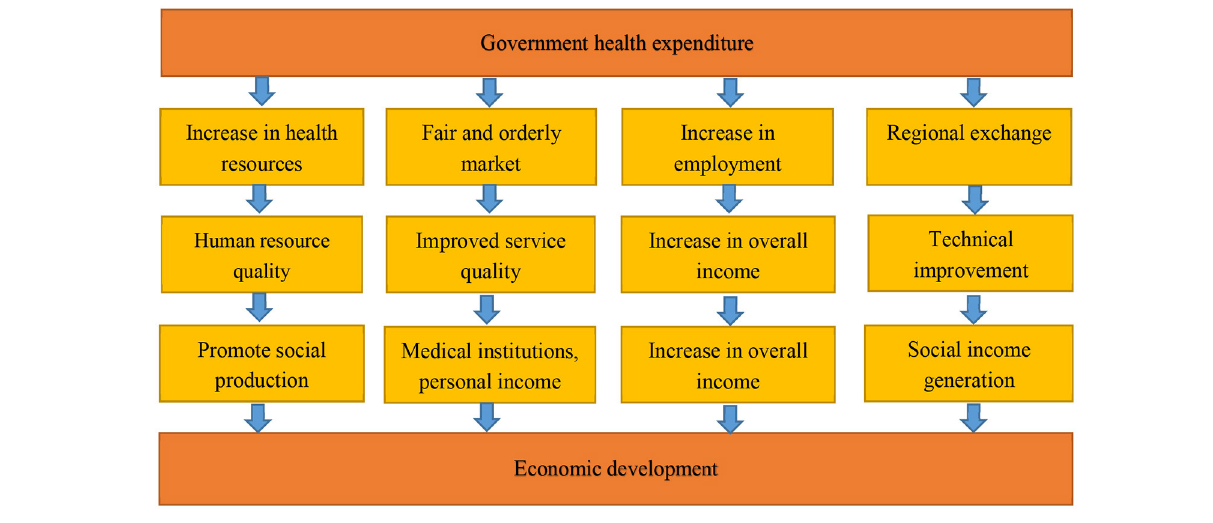
FIGURE 1 | Mechanistic conduction